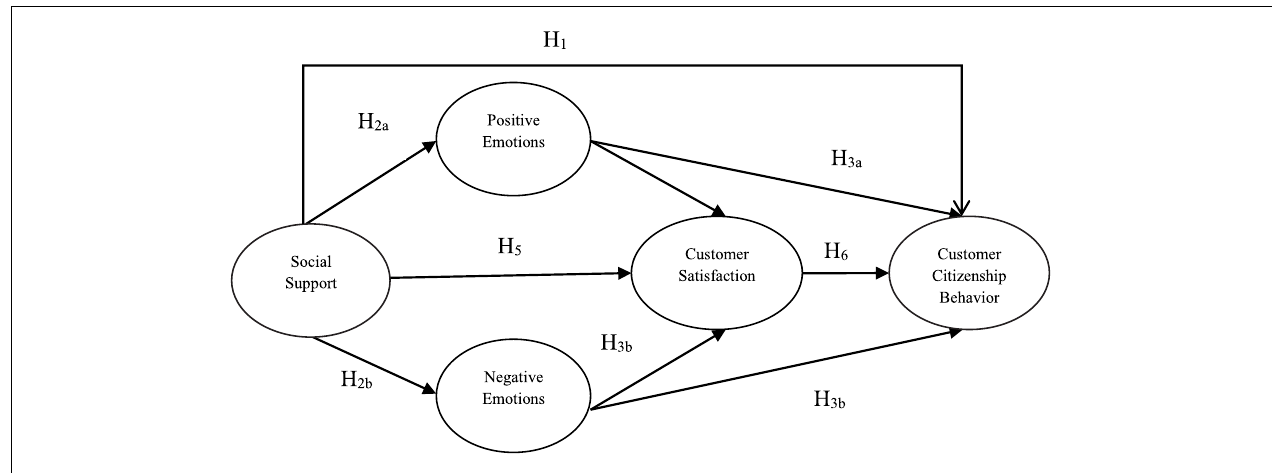
FIGURE 1 | Theoretical model on the impact of social support on customer citizenship